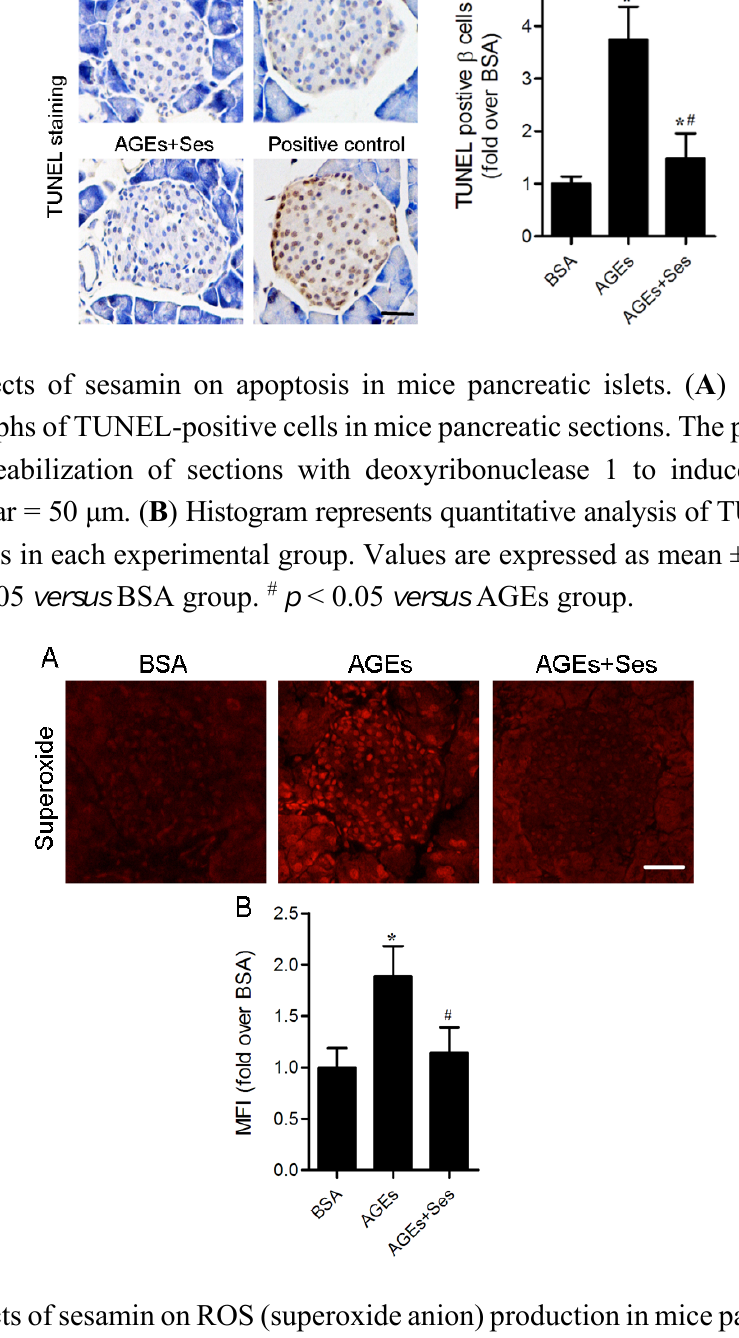
Figure 4. Effects of sesamin on ROS (superoxide anion) production in mice pancreatic islets. ( A ) Representative photomicrographs of mice pancreatic sections stained with DHE. Scale bar = 50 μ m. ( B ) Histogram represents quantitative analysis of superoxide anion generation in each experimental group. Values are expressed as mean ± SD, n = 6 per group. * p < 0.05 versus BSA group. # p < 0.05 versus AGEs group. MFI: Mean fluorescence